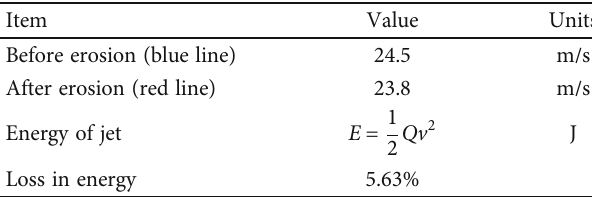
Table 5: Alteration of jet velocity and loss of